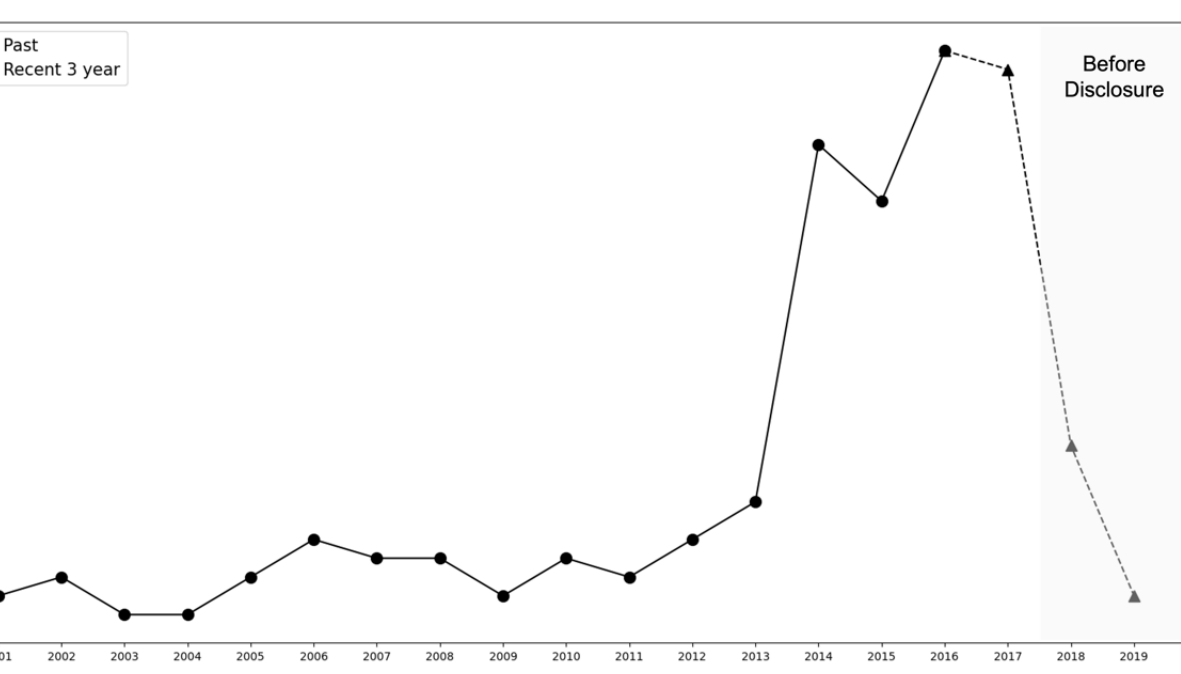
Table 7. Result of Ensemble Outlier Detection. Document No.